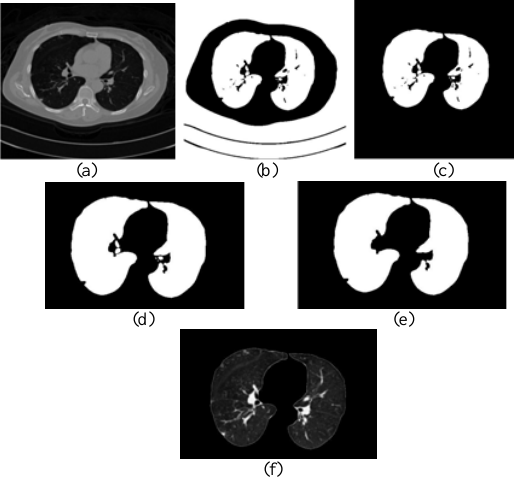
Fig. 4. Segmentation Results of Pulmonary Parenchyma. (a) original image, (b)optimal threshold segmentaton, (c)primary segmentaion result of Pulmonary Parenchyma, (d)filling up lung cavity, (e)eliminating trachea and bronchia, (f)mending image of pulmonary